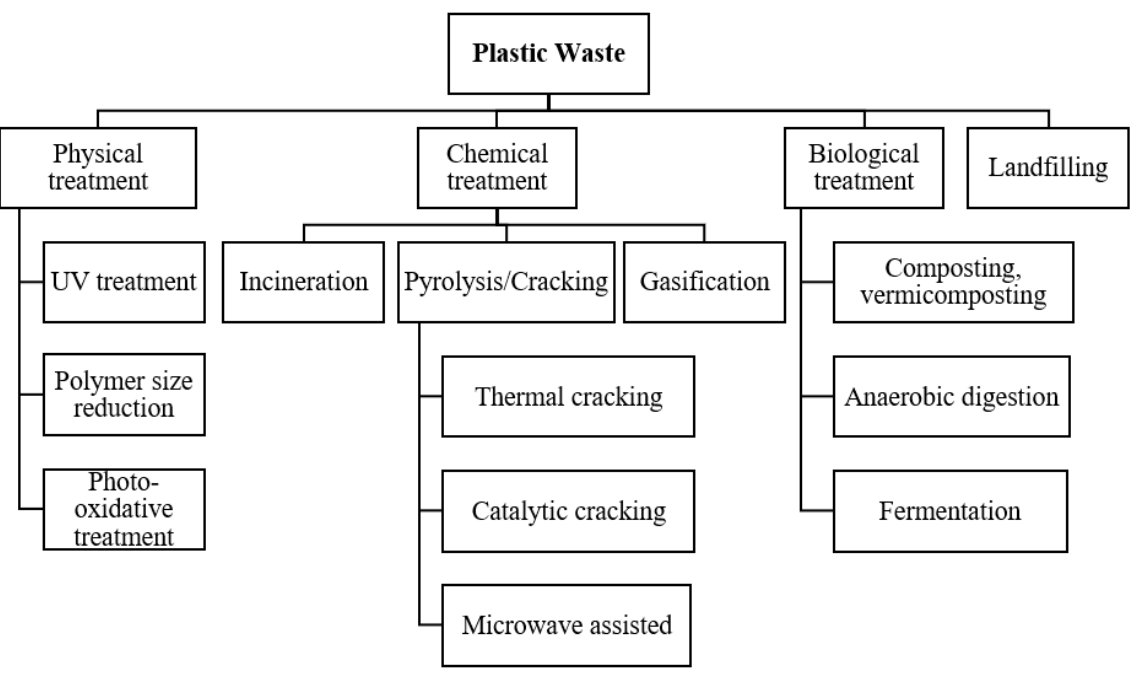
Figure 1. Pathways for plastic waste management .